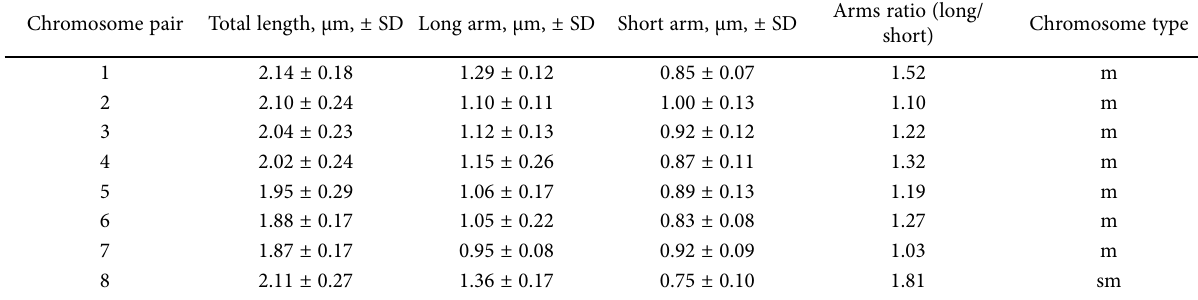
Table 1. Karyotype parameters of Agrimonia pilosa Ledebour, China (2 n =